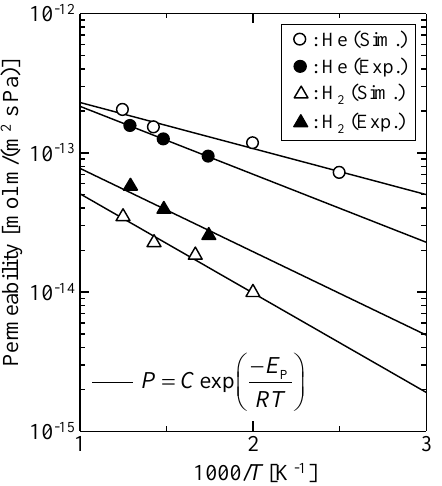
Figure 6. Temperature dependency of gas permeability: Comparison of simulation results and experimental data.